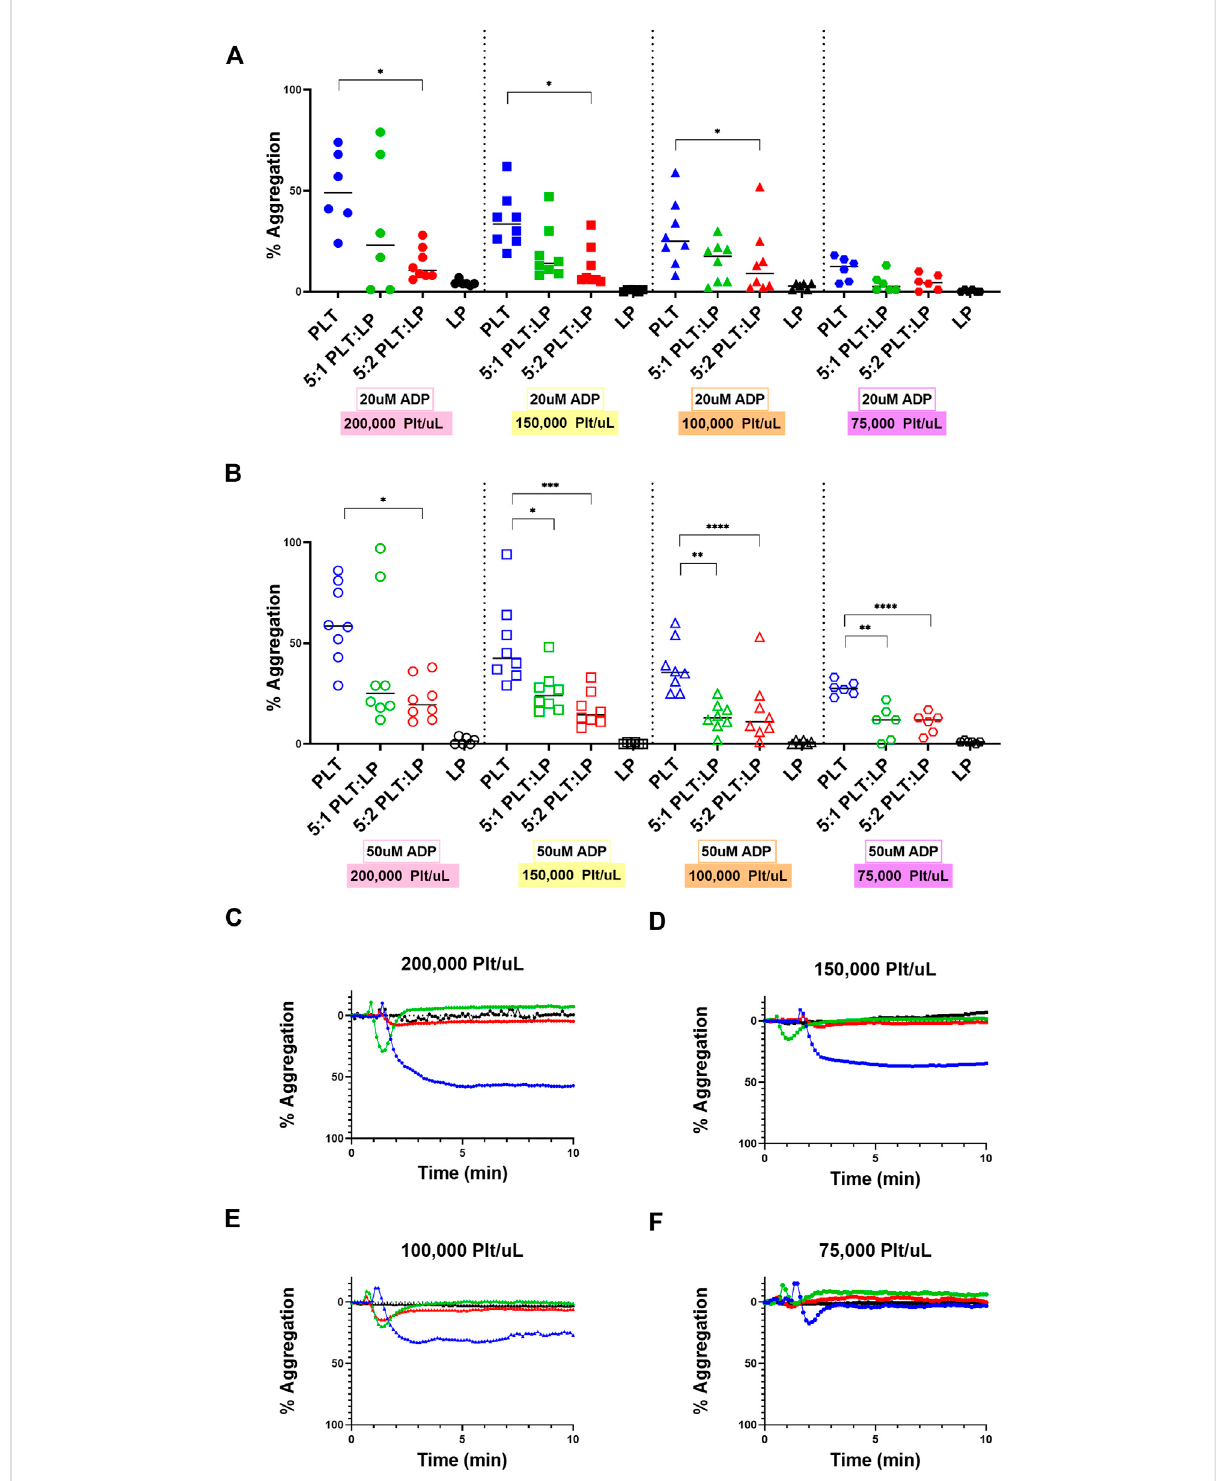
FIGURE 3 Aggregation ofPlateletsinthepresenceofLPsatDifferentConcentrationsandRatios.Quanti fi cation (A,B) andrepresentativeLTAcurves (C – F) for the aggregation of platelets compared to platelets mixed with LPs at ratios of 5:1 and 5:2 platelets to LPs using ADP agonist at concentrations of 20 uM (A; shown in representative fi gures (C – F) and 50 uM (B) using healthy platelet levels of (C) 200,000 platelets/uL [donors = 4, n = 8] and (D) 150,000 platelets/uL [donors = 4, n = 8], as well as thrombocytopenic platelet levels of (E) 100,000 platelets/uL [donors = 4, n = 8] and (F) 75,000 platelets/uL [donors = 3, n = 6] for all ratios. LP alone conditions are included for each platelet condition as a